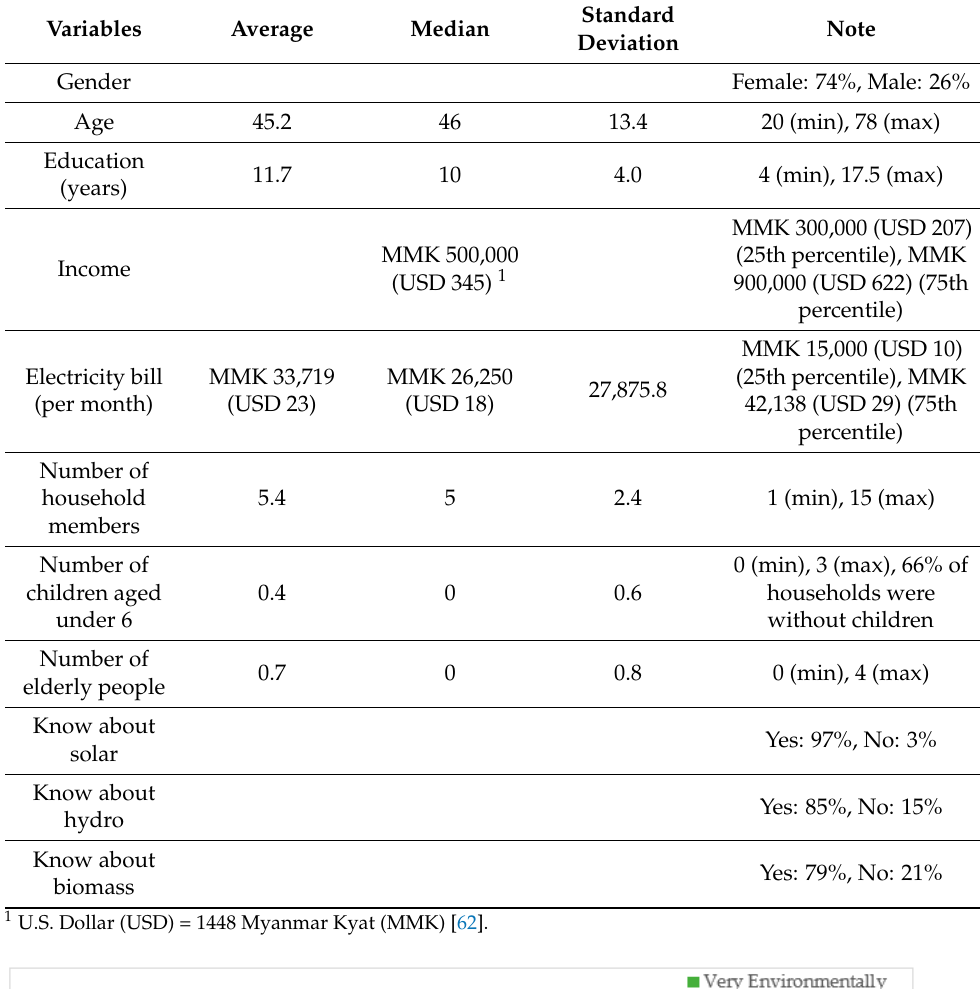
Table 3. Socio-demographics of respondents.